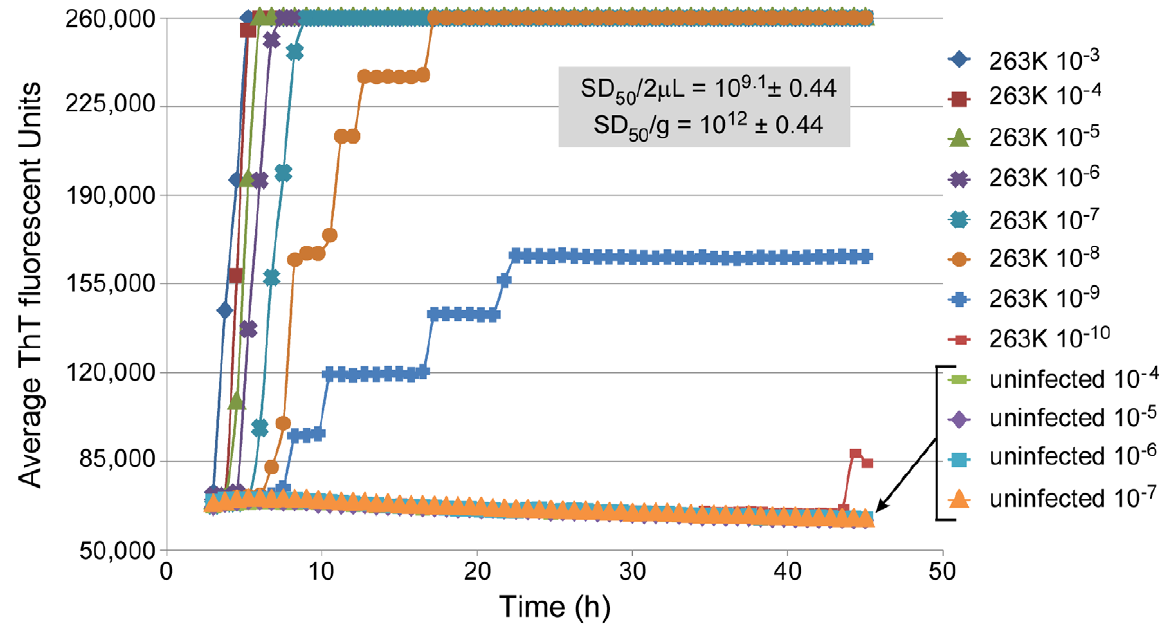
Figure 1. RT-QuIC sensitivity: analysis of dilutions of a scrapie brain homogenate stock. The designated dilutions of 263K scrapie or normal BH were used to seed RT-QuIC reactions containing recombinant hamster PrP c 90-231 substrate. Each 0.75 h time point for each dilution is represented as an average ThT fluorescence from 8 replicate wells on a 96-well plate. The 50% seeding dose (SD 50 ) is defined as the amount giving sufficiently enhanced ThT fluorescence in half of the replicate wells. In this case, the approximate SD 50 was achieved with a 2 m l aliquot (the seed volume) of a 10 2 9 dilution of the scrapie BH stock. The Spearman-Ka¨rber estimate of the SD 50 /2 m l neat brain tissue is shown, along with that adjusted to SD 50 /gram brain tissue.